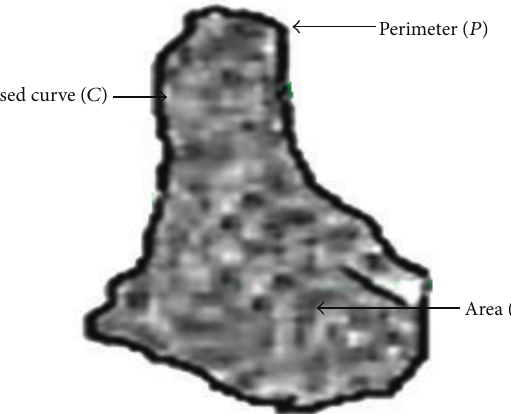
Figure 3: Illustration of the parameters for the slit island